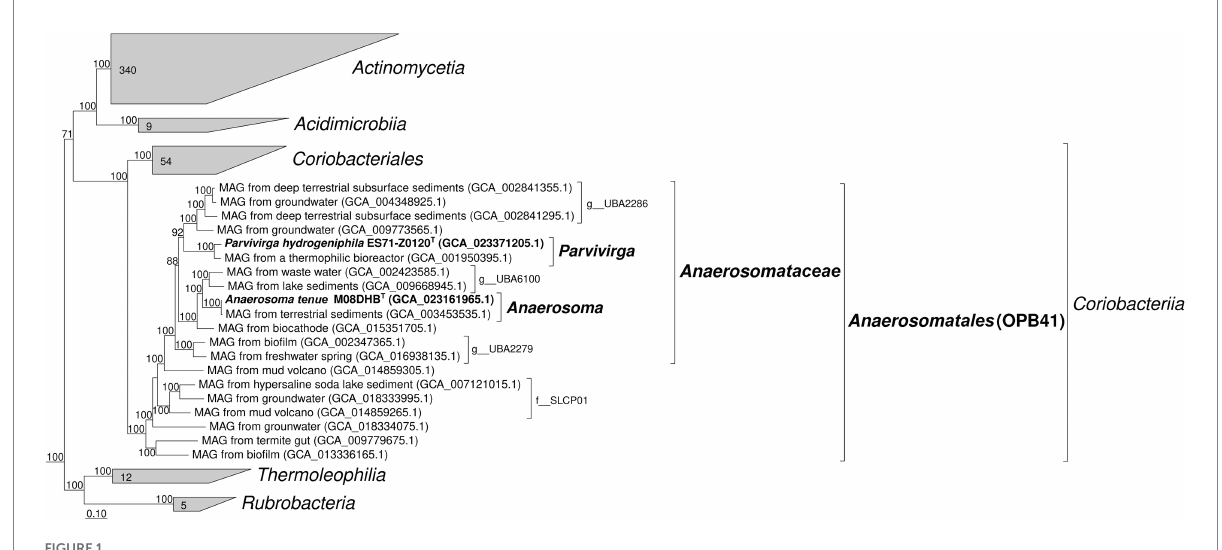
FIGURE 1 Phylogenomic placement of strains M08DHB T and Es71-Z0120 T within the Actinomycetota phylum based on concatenated partial amino acid sequences of 120 bacterial single copy conserved marker genes with taxonomic designations according to the Genome Taxonomy DataBase. Bootstrap consensus tree is shown with values above 70%, placed at the nodes. Bar, 0.1 changes per